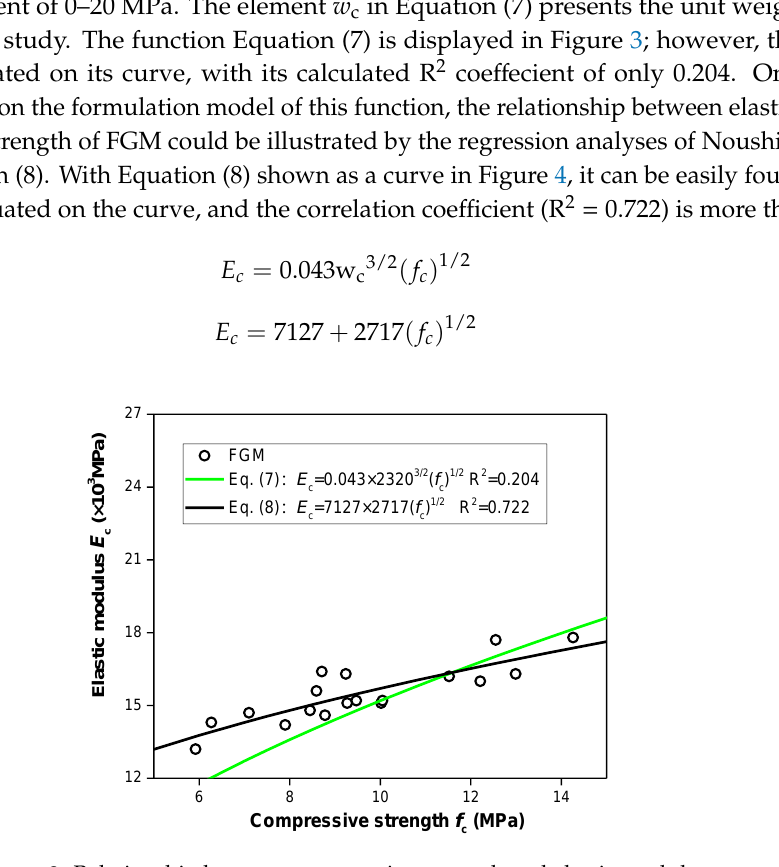
Figure 3. Relationship between compressive strength and elastic modulus.